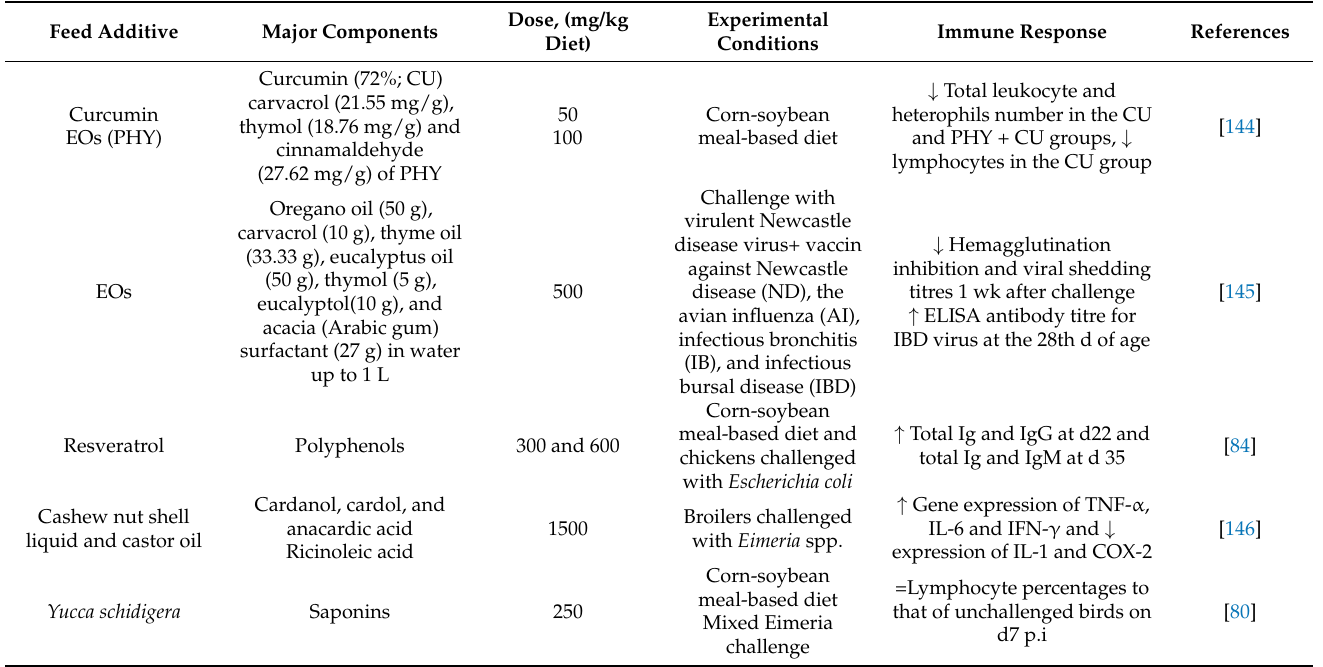
Table 6. Effects of dietary PFA supplementation on immunity of